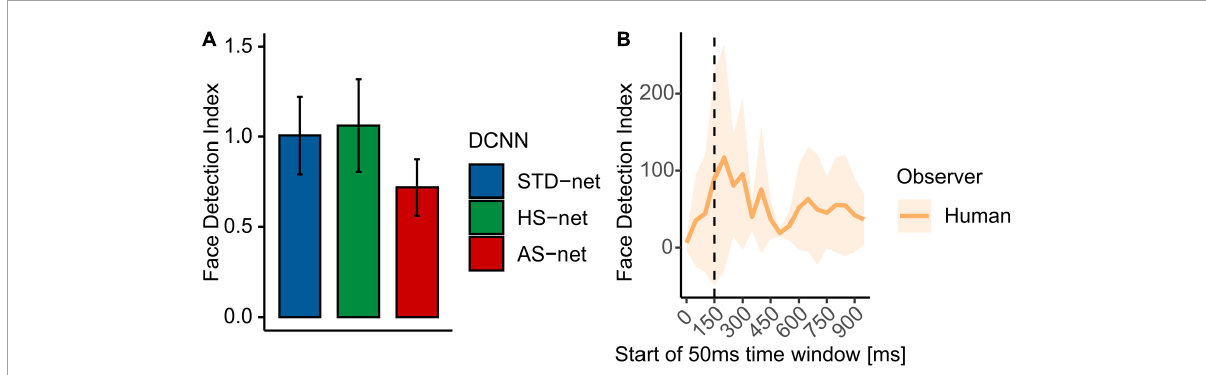
FIGURE4 Mean face detection indices. The face detection index reflects the proportional attention within compared to outside of the face ROI. (A) Mean face detection indices for GradCAMs overall. (B) Mean face detection index for eye tracking heatmaps across time. Shaded areas display bootstrap confidence intervals. The dotted line marks the transition from feedforward to recurrent processing at ∼ 150 ms.